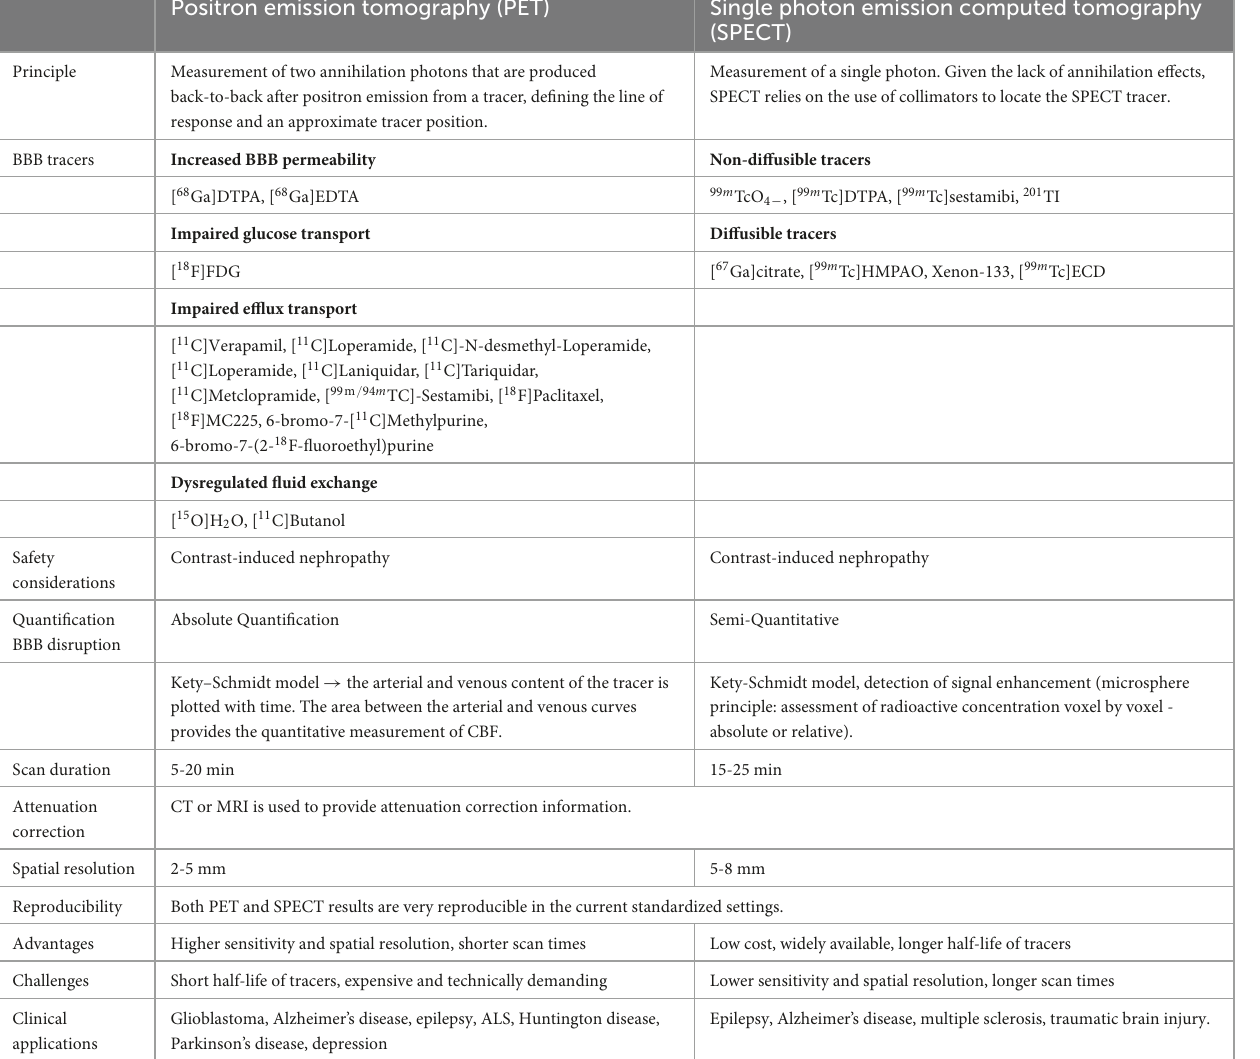
TABLE 1 Comparison of SPECT and PET imaging. Positron emission tomography (PET) Single photon emission computed tomography Principle Measurement of two annihilation photons that are produced back-to-back after positron emission from a tracer, defining the line of response and an approximate tracer